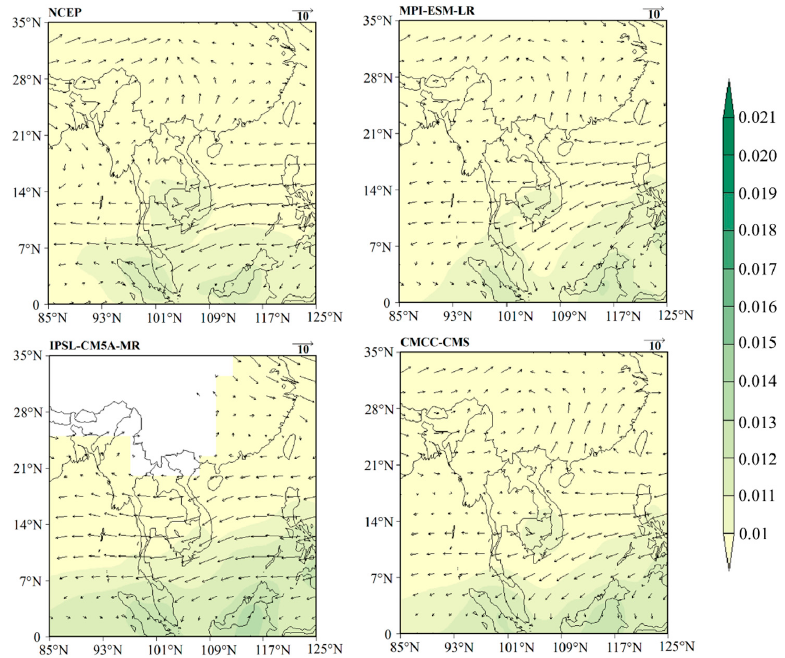
Figure 11. Mean monthly specific humidity (shaded) and wind (vector) for the dry season of the period 1975–2004 for the NCEP and the three best-ranked GCMs over the LMB.